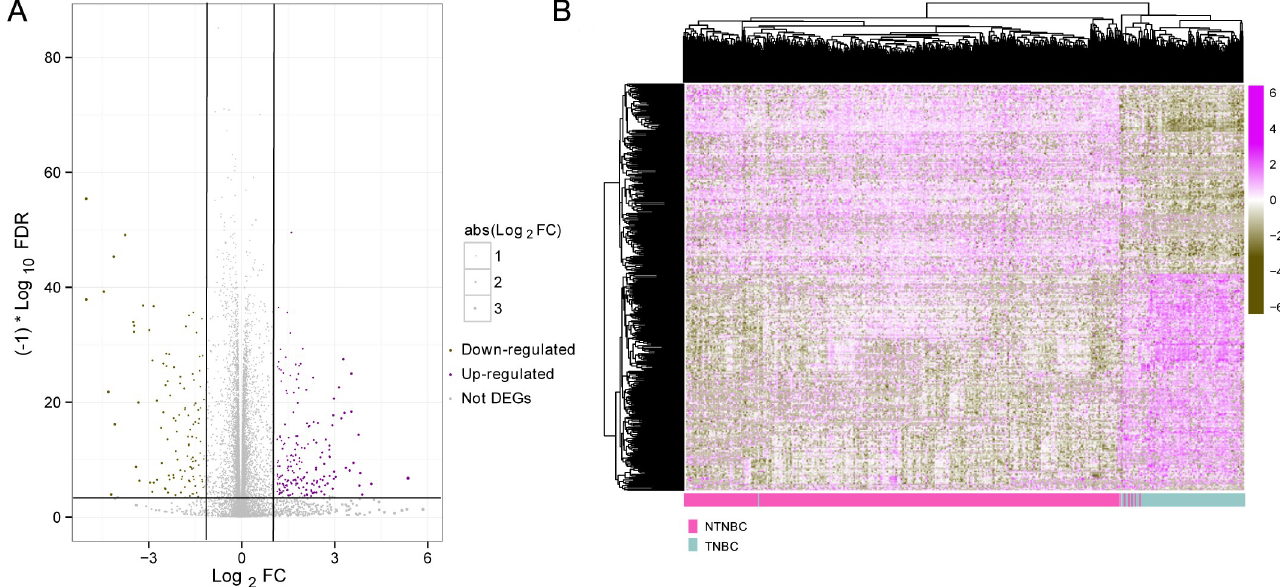
Fig 1. The DEGs detection analysis. (A) The volcano map of the mRNAs. Horizontal dashed lines represent false discovery rate < 0.05, and two vertical dashed lines represent |log 2 Fold Change| > 1. The size of the dots represents the absolute log 2 Fold Change, and the larger the value, the larger the point. (B) A two-way hierarchical clustering heat map based on the expression level of DEGs. DEGs, differentially expressed